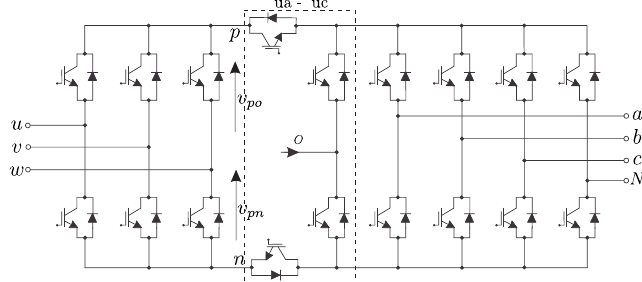
Figure 23. Three-level indirect matrix converter.